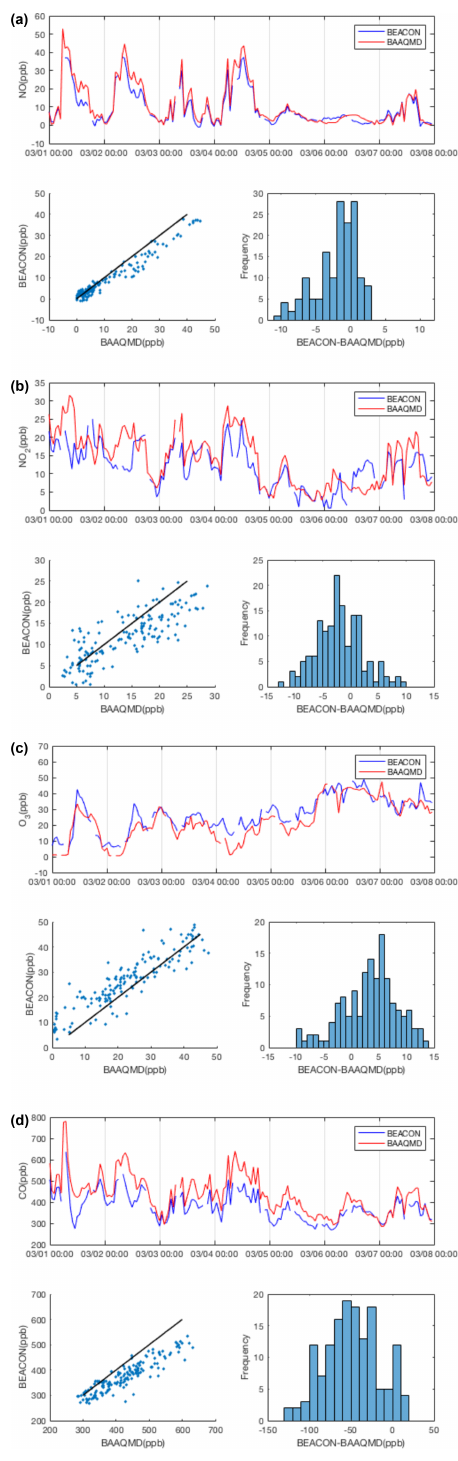
Figure 6. Time series (top), direct comparison (bottom left), and histogram (bottom right) of hourly averaged (a) NO, (b) NO 2 , (c) O 3 , and (d) CO mixing ratios from a representative week of cal- ibrated BEACO 2 N and BAAQMD reference data. The black lines in the bottom left plots indicate the 1 : 1